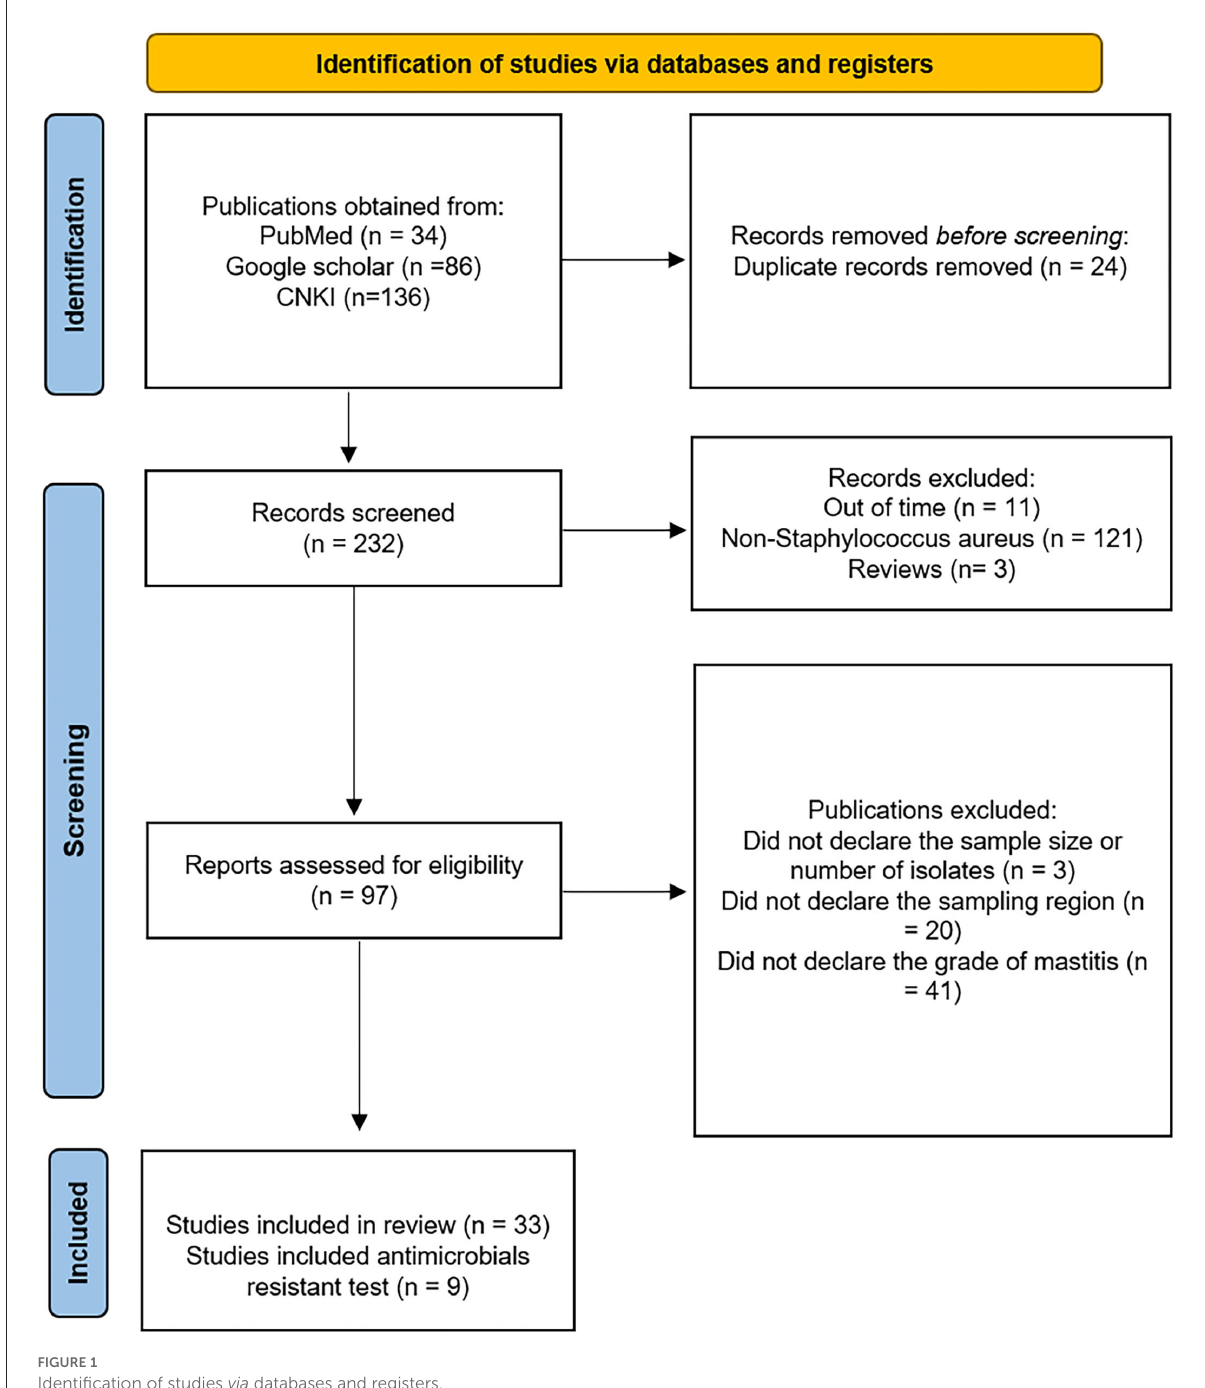
FIGURE1 Identification of studies via databases and registers.